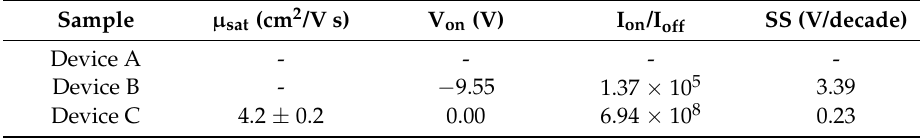
Table 1. Electrical parameters of a-STO TFTs with post-annealing in argon ambient.